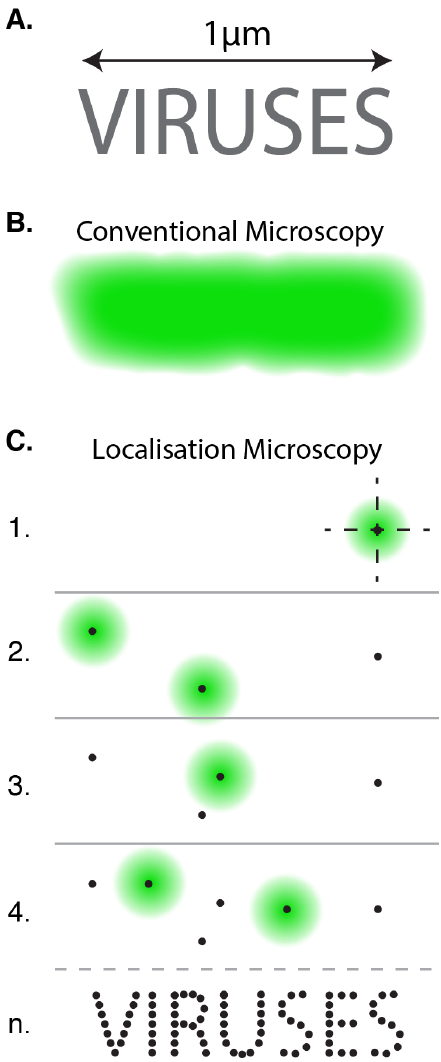
Figure 2. Localisation Microscopy. ( A , B ) The ultrastructure of a fluorescently labeled nanoscale object cannot be discerned by conventional microscopy as the signals from apposing fluorophores merge together. ( C ) In localisation microscopy fluorophores